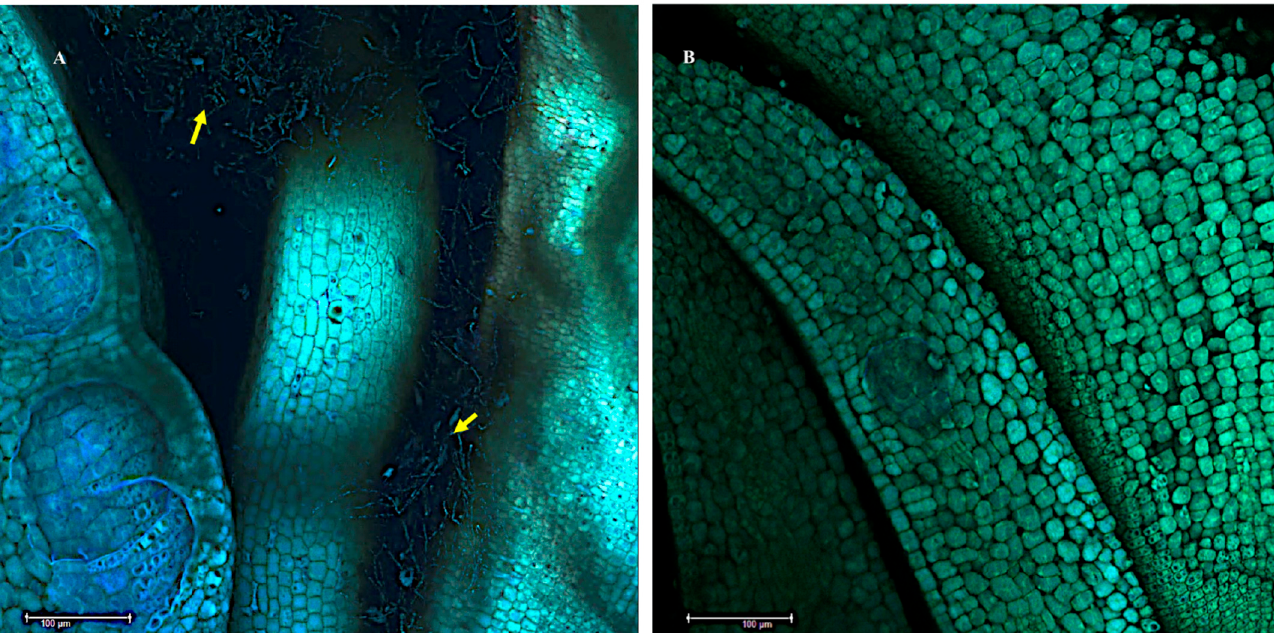
Figure 6. Fluorescent laser scanning confocal microscope images showing massive network of mycelia colonizing the intercellular spaces in the hypocotyl region of positive Ipomoea carnea seeds indicated by the arrows ( A ). No colonization of mycelia was observed in the hypocotyl region from a negative seed ( B ). Scale bar—100 μ m.